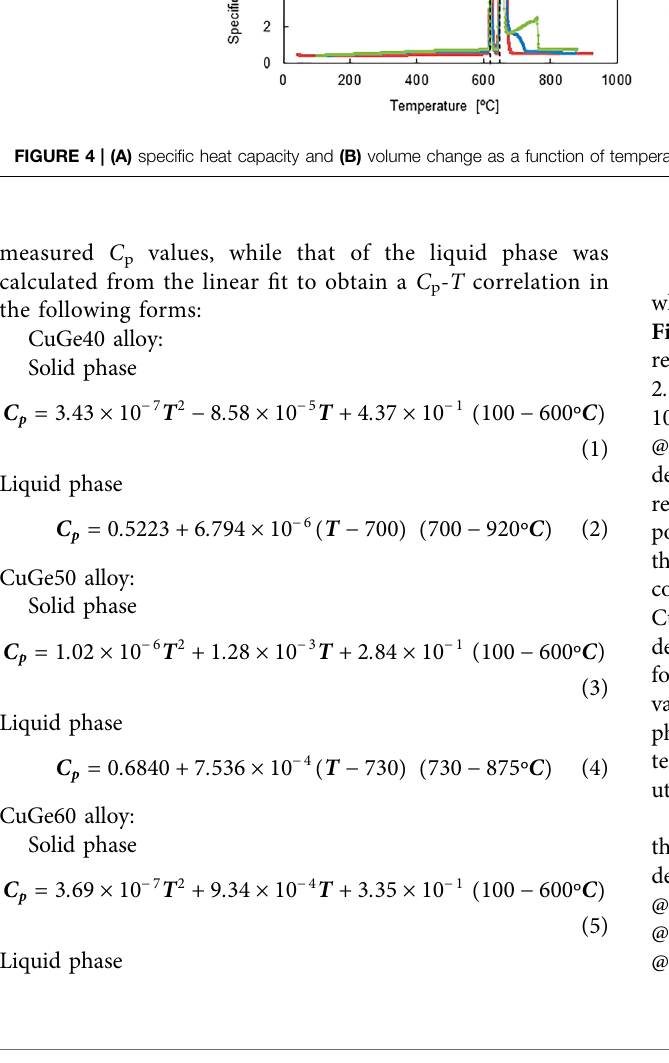
Frontiers in Energy Research |